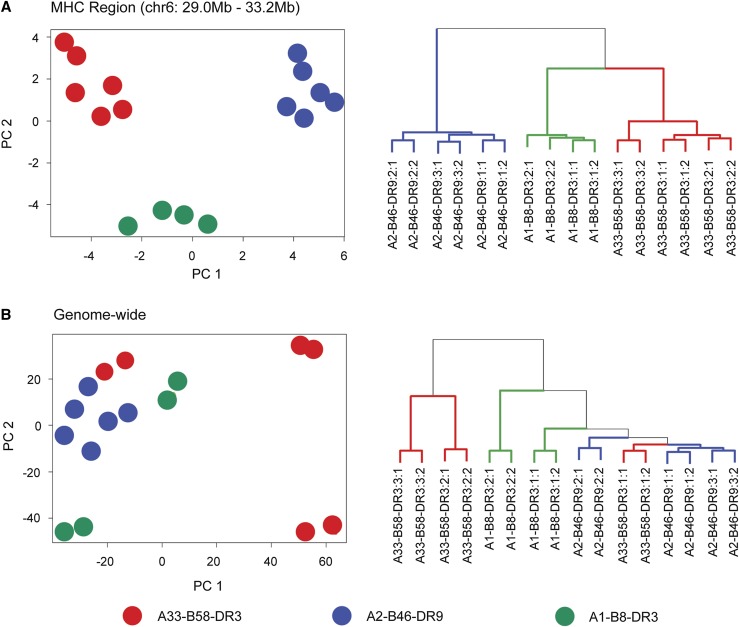
MHC-wide gene expression patterns defined by MHC haplotypes. (A) Hierarchical and PC analysis based on expression of 177 MHC-residing loci found within chr6:29.0–33.2 Mb. (B) Hierarchical and PC analysis based on expression of genes in the human genome. Expression profiles were derived from RNA-sequencing of eight B-LCLs with two libraries generated per B-LCL. Blue indicates B-LCLs carrying the A2-B46-DR9 haplotype, red indicates B-LCLs carrying the A33-B58-DR3 haplotype, and green indicates B-LCLs carrying the A1-B8-DR3 haplotype. B-LCL, B-lymphoblastoid cell line; chr, chromosome; MHC, major histocompatibility complex; PC, principal component.